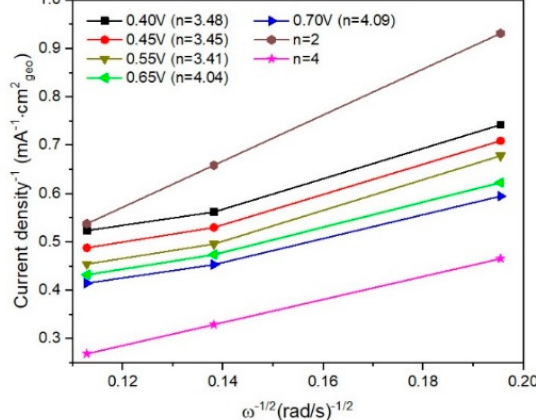
Figure 8. Linear sweep voltammograms for I/rGO at various rotation speeds (250 to 1000 rpm) on RDE.